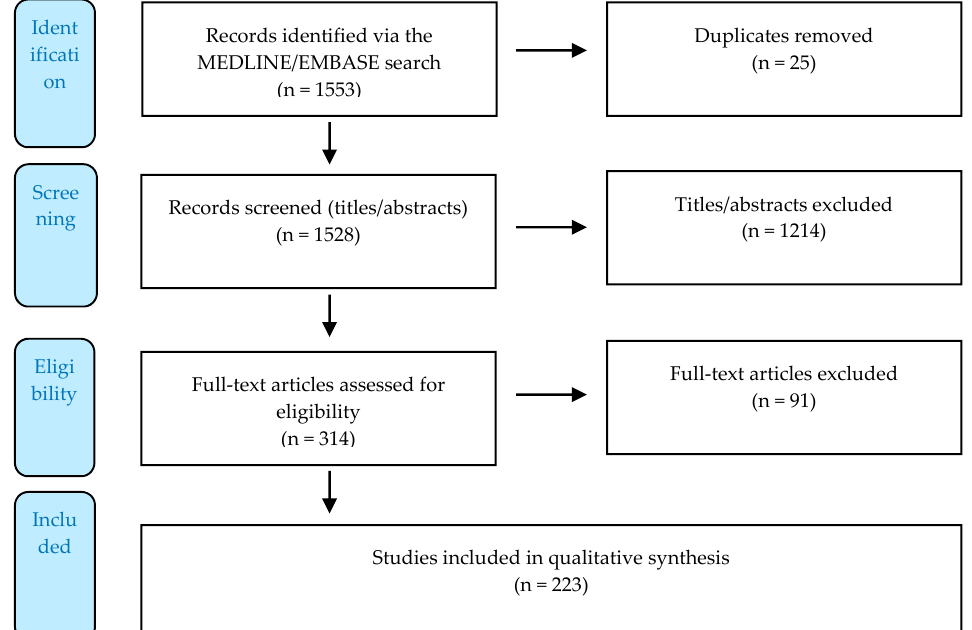
Figure 1. Flow diagram displaying the number of records identified, included, and excluded via a systematized literature review following Preferred Reporting Items for Systematic Reviews and Meta-Analyses (PRISMA) guidelines [300]#.